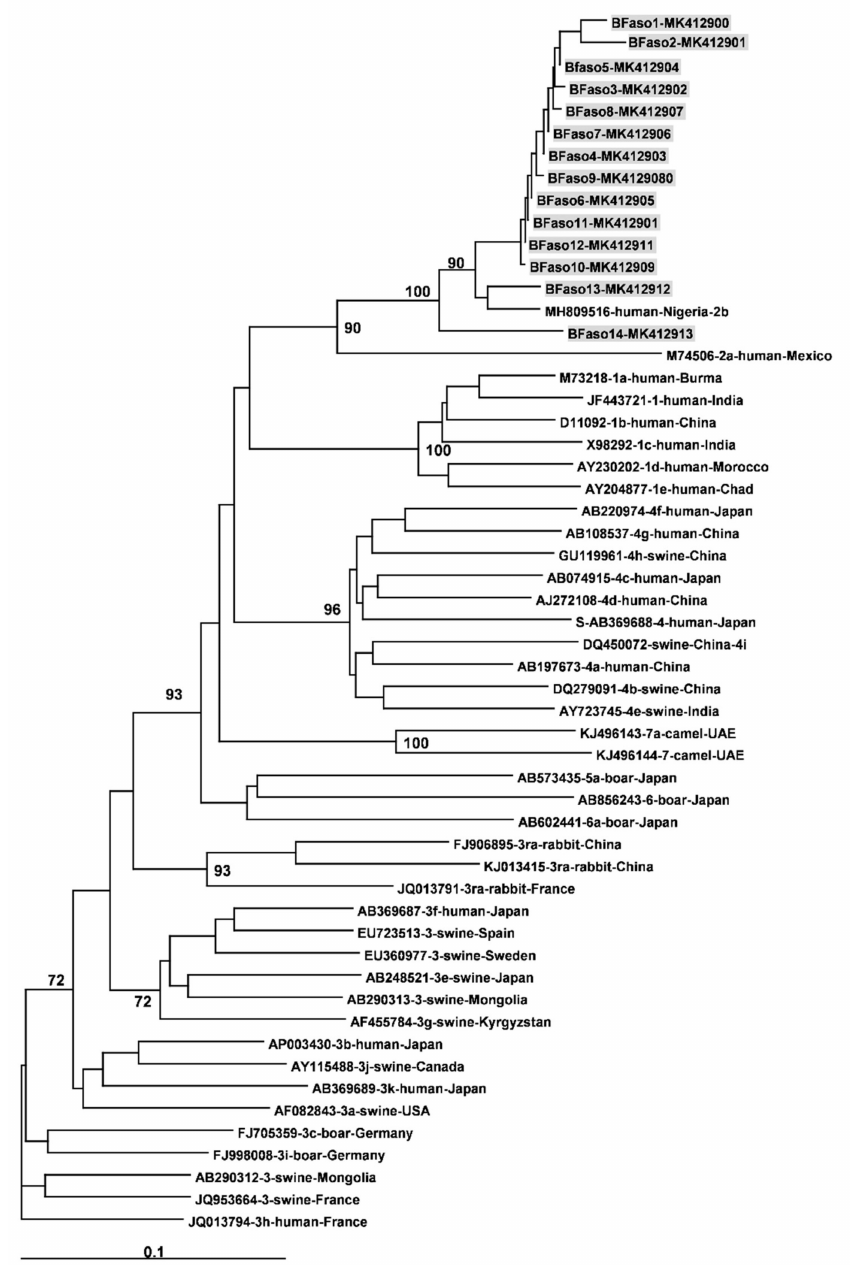
Figure 2. Phylogenetic tree constructed using 347-nt-long partial sequences within ORF2 (black dots). Genetic distances were calculated using the Kimura two-parameter method, phylogenetic trees were plotted by the neighbour-joining method. Bootstrap values acquired after 100 replications are shown (branch lengths measured as the number of substitutions per site). Highlighted patient sequences (grey boxes) were compared to reference sequences (Smith et al., 2016) and to the new full length of subtype 2b strain (MH809516). Accession numbers, genotypes, and country of origin of collections are